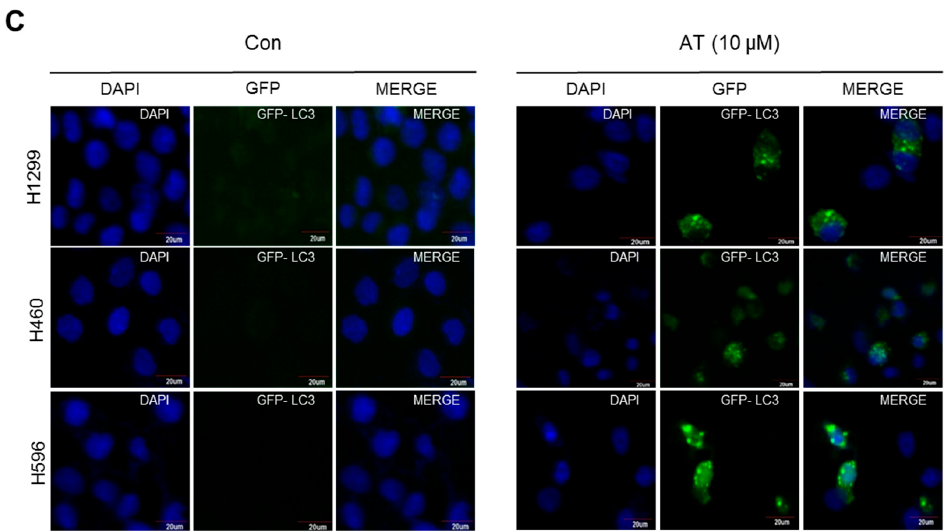
Figure 3 . Atorvastatin induces autophagy in H596, H460, and H1299 cells. ( A ) Effect of Atorvastatin on p62/SQSTM 1, LC3I/II, and CNOT2 for 24 h or 48 h in a time course. Western blotting was performed with antibodies of p62/SQSTM 1, LC3I/II, and CNOT2 in Atorvastatin (10 μΜ ) treated H596, H460, and H1299 cells. ( B ) Effect of Atorvastatin on p62/SQSTM 1, LC3I/II and CNOT2 in Atorvastatin treated H596, H460, and H1299 cells in a concentration dependent fashion. Three NSCLCs were treated with various concentrations of Atorvastatin (0, 5, 10, and 20 μ M) and were subjected to Western blotting with antibodies of p62/SQSTM 1, LC3I/II and CNOT2 in H596, H460, and H1299 cells. ( C ) Effect of Atorvastatin on GFP-LC3 puncta in H1299 cells by Immunofluorescence assay. H596, H460, and H1299cells were transfected with GFP-fused LC3 plasmid and also exposed to Atorvastatin (10 μ M) for 48 h. Then the distribution of GFP-LC3II expression was visualized by confocal microscopy. Bar scale = 20 μ m, DAPI-blue, GFP-LC3-Green.